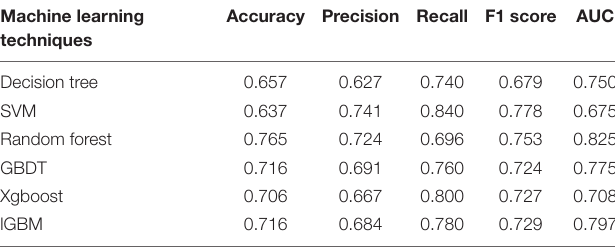
TABLE 4 | The metrics of different machine learning models. Machine learning techniques